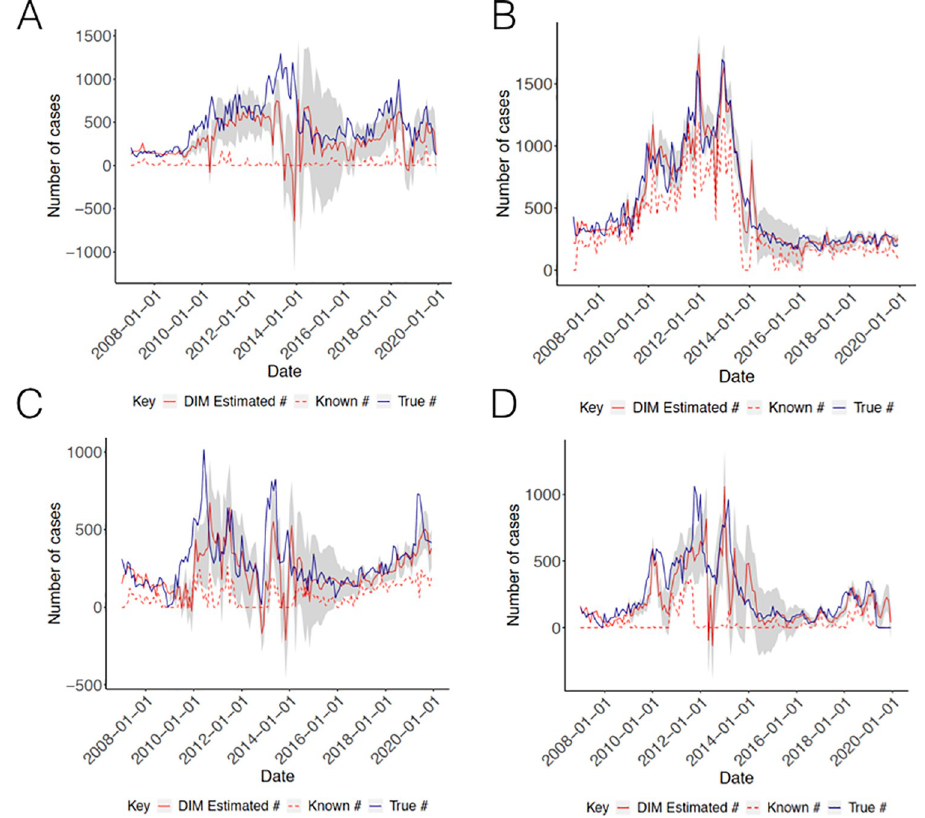
Fig 3. Results from Data Imputation Models. (A) Regions 1 (B) Region 4 (C) Region 7 and (D) Region 8. Solid red lines indicate the number of cases estimated from the data imputation model, dashed red lines indicate the number of cases known by the end of the month and solid blue lines indicate the true number of eventually reported cases. Grey bands capture the moving 95% confidence intervals for each model.